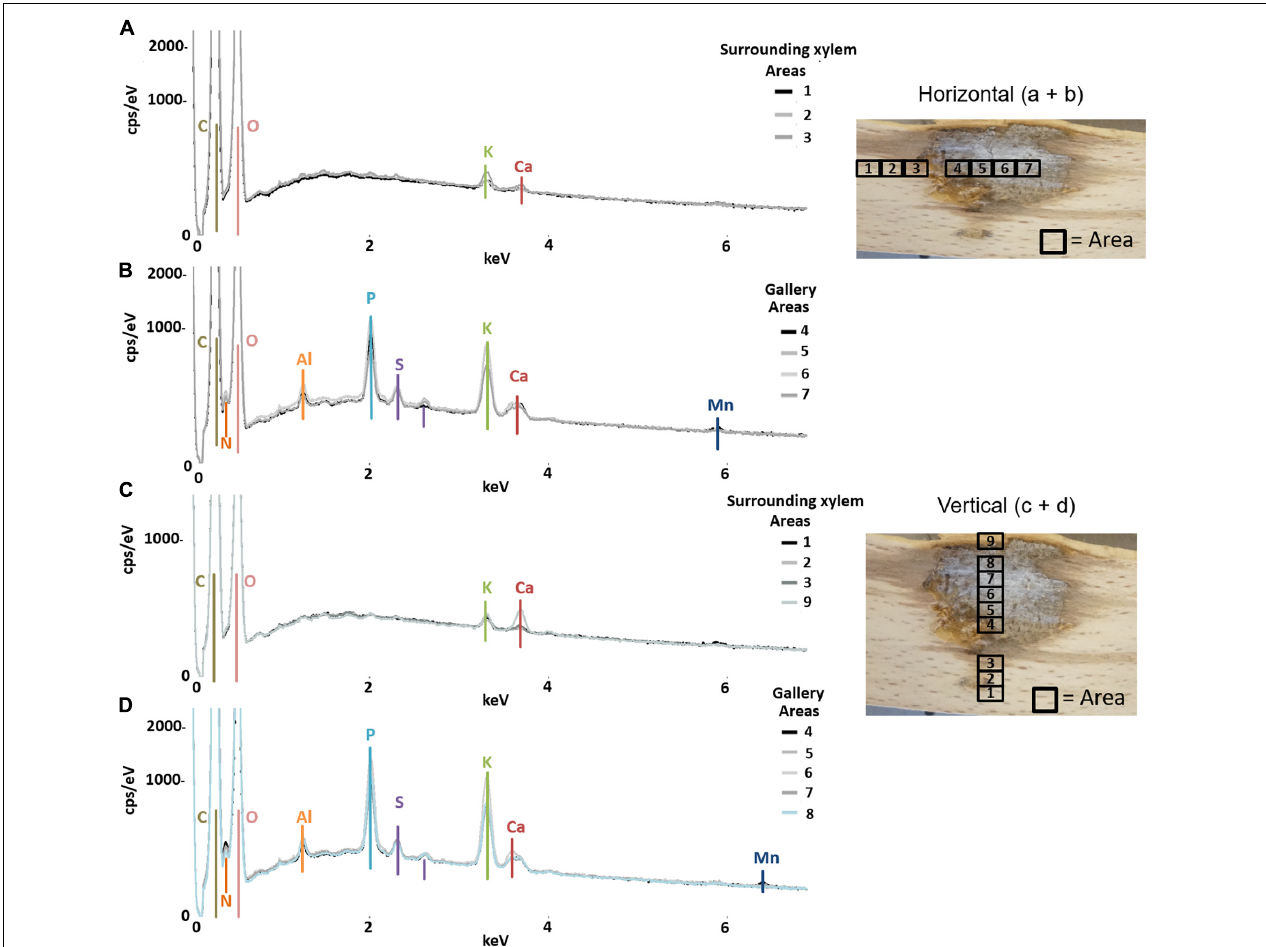
FIGURE 1 | Elemental composition of gallery walls and xylem surrounding a gallery of Xyleborinus saxesenii (ID = X.sax13) using SEM-EDX. The gallery was examined in horizontal (A,B) and vertical (C,D) direction respective to wood grain; location and numbers of measured areas are given on the right. The Y -axis of each plot is counts per second () per electronvolt (eV) of each element, while the X -axis is the applied electricity in kilo-electronvolt (keV).